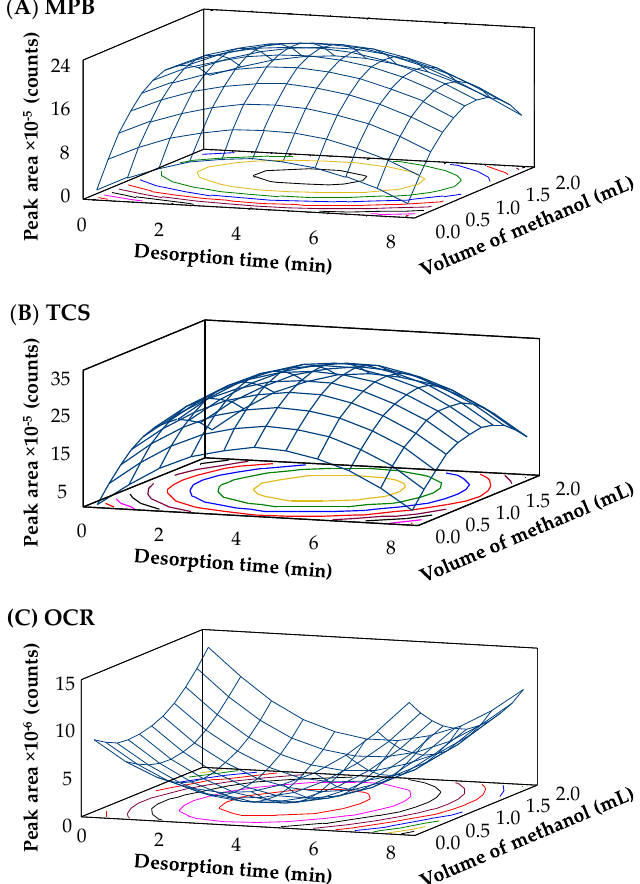
Figure 5. Surface responses obtained for representative PCPs: ( A ) MPB, ( B ) TCS, and ( C ) OCR, obtained through the statistical study of the Doehlert experimental design.